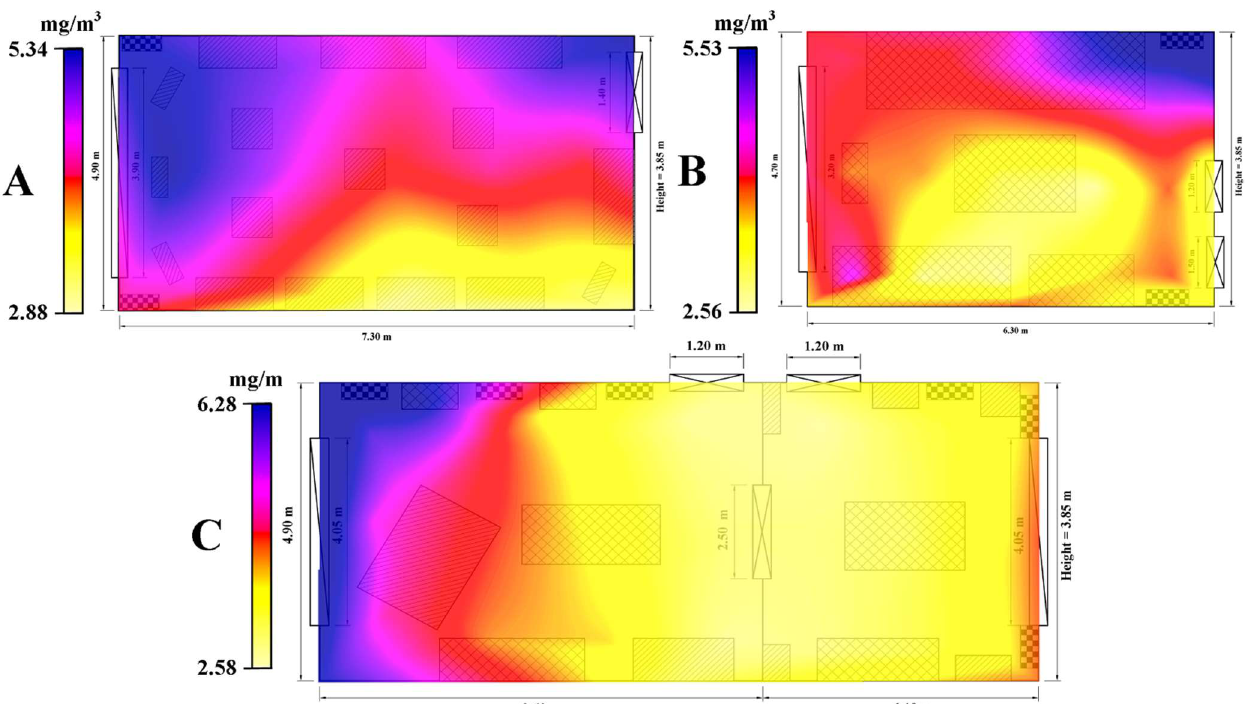
Figure 8. Spatial distribution of the concentration of volatile organic compounds (VOC) in the three analyzed rooms of Darvas-La Roche House–taking into account the average of each data collection position for the entire measured period (( A )—Exhibition hall–Ground floor; ( B )—Bedroom–1st floor; ( C )—The great hall–1st floor).